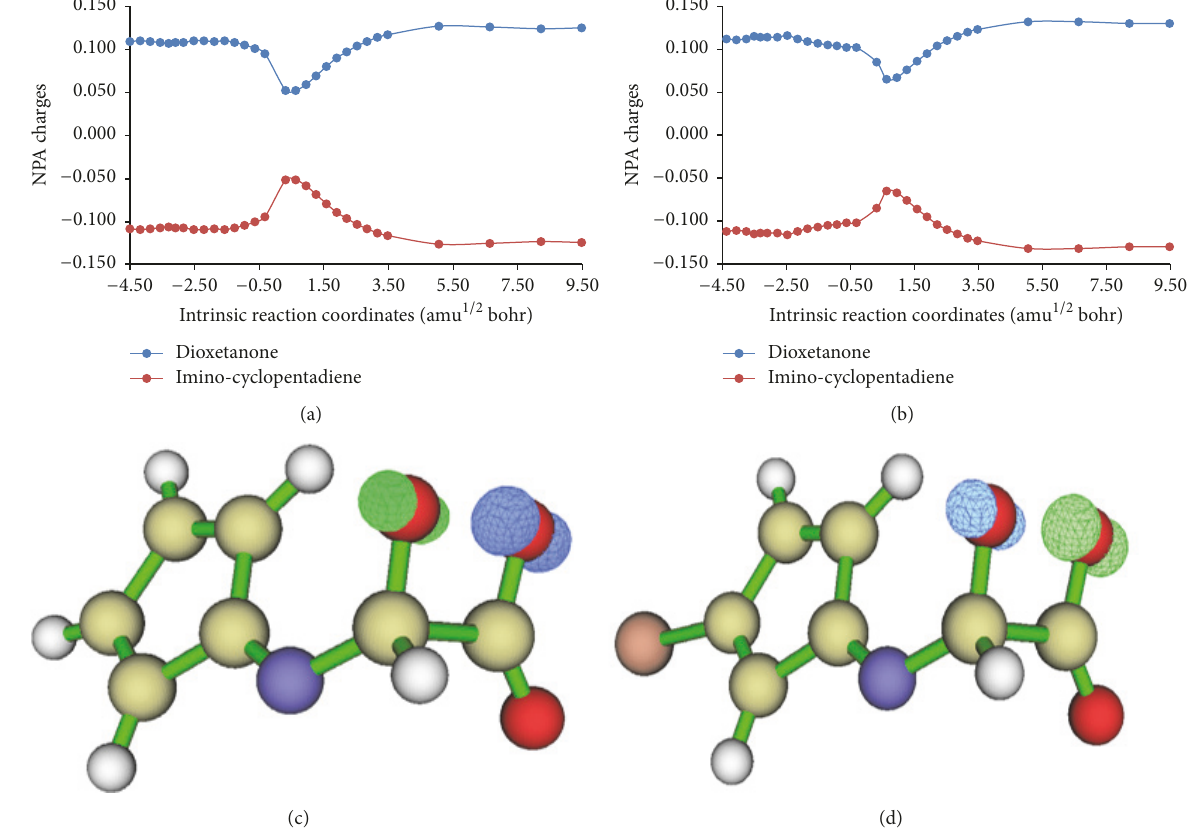
Figure 2: NPA charge density distribution between the dioxetanone and imino-cyclopentadiene moieties, for species IVa (a) and IVb (b). Electron spin density for the transition state structure of the thermolysis of IVa (c) and IVb (d).